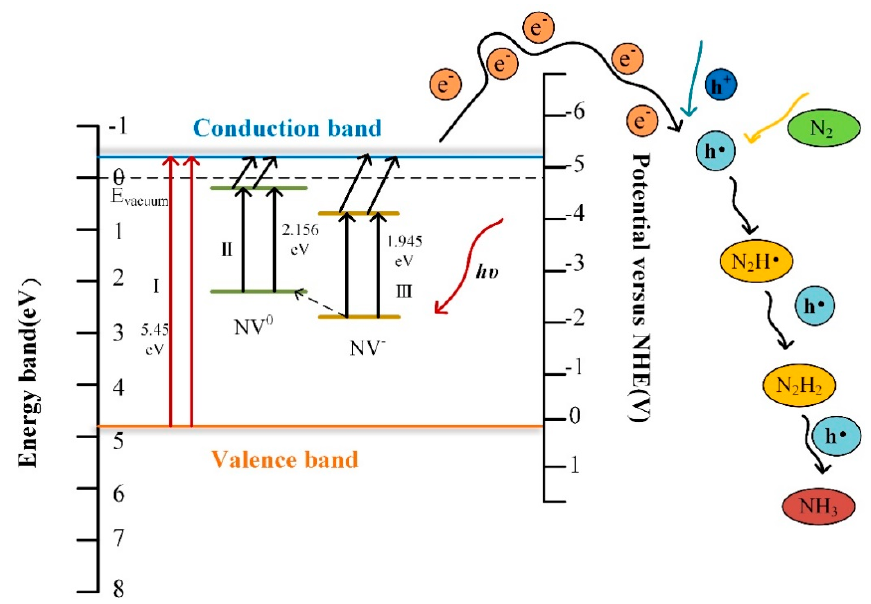
Figure 7. The schematic diagrams of the influence of nitrogen levels on diamond photocatalysis. Step I in the photocatalyst for reduction is intrinsic excitation. The presence of nitrogen levels in diamond can be illustrated in the second step II (the neutral state of NV 0 ) and third step III (the negatively charged state NV − ).